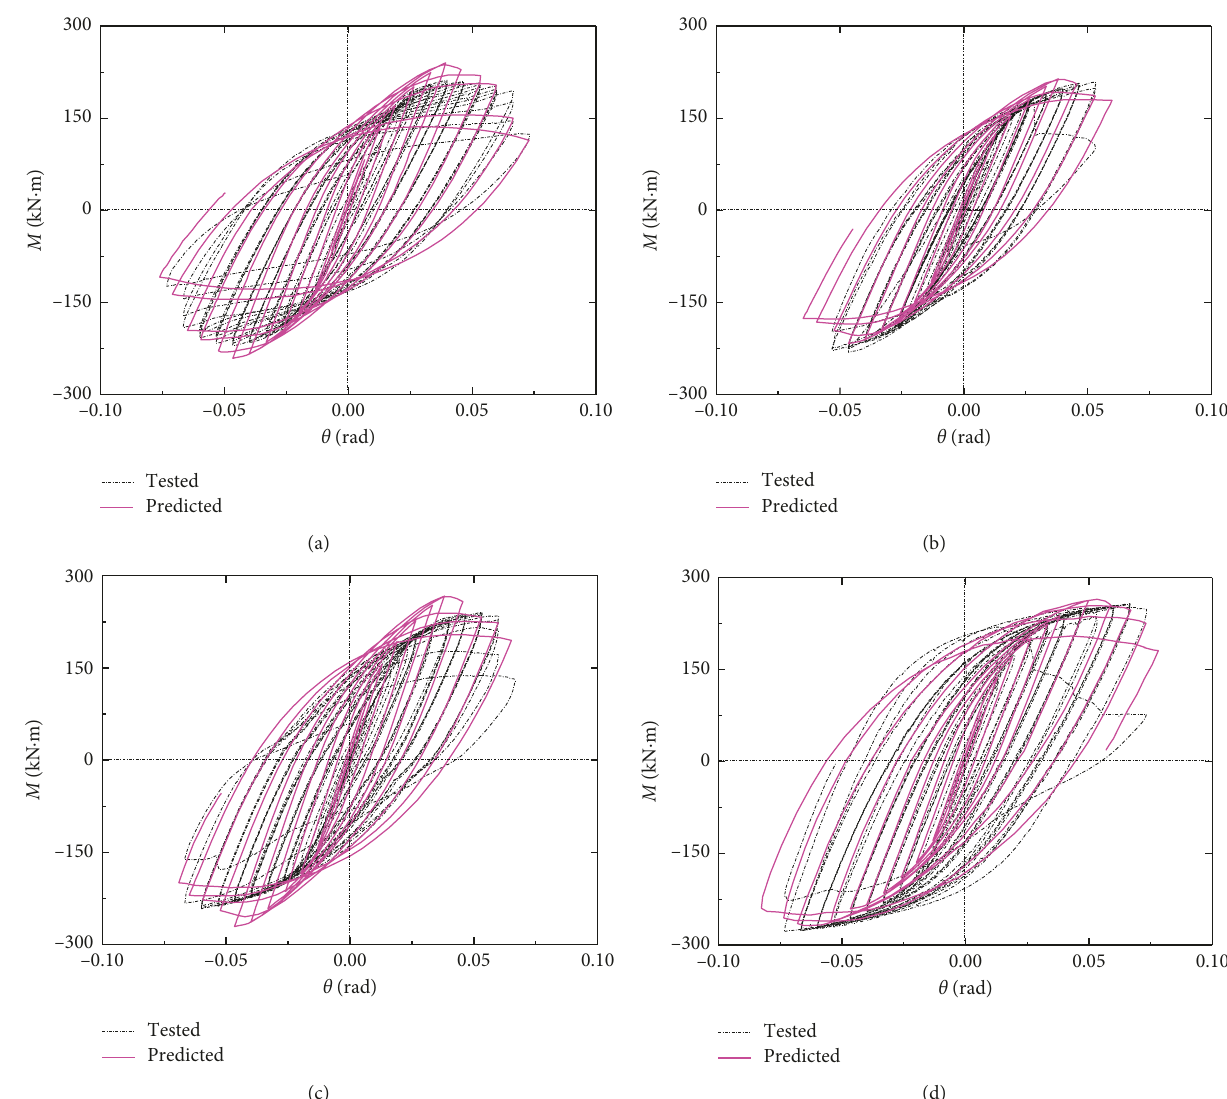
Figure 14: Comparison of the hysteresis curves obtained from the test and FEA results. (a) SBJ1-1. (b) SBJ1-2. (c) SBJ2-1. (d) SBJ2-2.